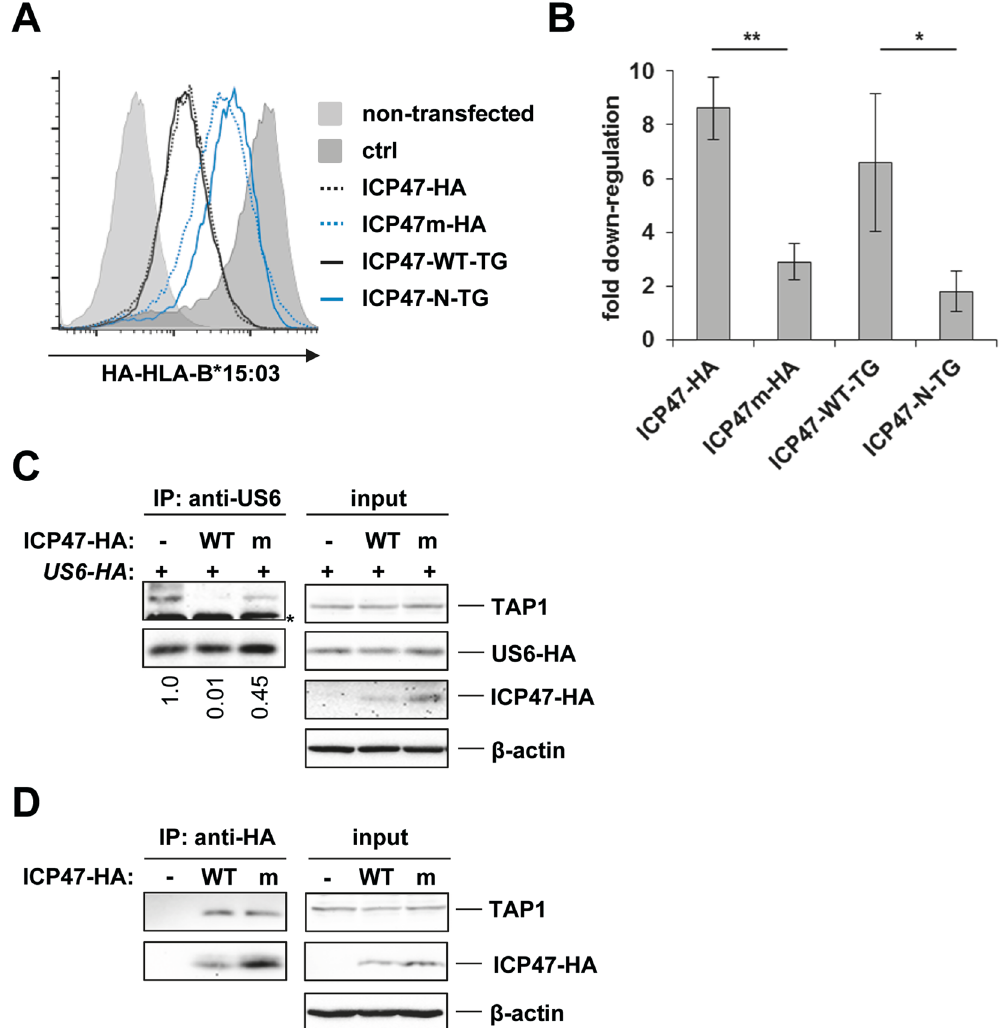
Figure 3. The highly conserved ICP47 residues 50–52 are required for freezing of the TAP conformation. ( A ) HeLa cells were transiently transfected with HA-HLA-B * 15:03, a control (ctrl) or ICP47 constructs as indicated and a plasmid encoding EGFP for gating of transfected cells. At 20 h post-transfection HA- HLA-B * 15:03 surface expression was analyzed by FACS using anti-HA antibodies. One representative experiment out of four independent experiments is shown. ( B ) Relative downregulation of HA-HLA-B * 15:03 was determined by dividing the MFI value of the control sample by the MFI of indicated samples. Mean values of four independent experiments are shown. Statistical analyses were performed applying one-way analysis of variance, ANOVA (Bonferroni), * P < 0.05. ( C ) Control HeLa cells ( − ) or HeLa cells stably expressing WT or mutant (m) ICP47-HA were transiently transfected with US6-HA. At 20 h post-transfection cells were lysed in digitonin lysis buffer and an IP was performed an anti-US6 antiserum. Recovered proteins (IP) and aliquots of the lysates (input) were separated by SDS-PAGE and detected in Western blot (TAP1, 148.3; ICP47-HA and US6-HA, anti-HA). The relative intensity of the TAP1 band compared to the US6-HA band in the IP samples is given below the upper panel. The value of the control sample was set to 1. One representative experiment out of three independent experiments is shown. The asterisk indicates the HC of the antibody used for IP. ( D ) HeLa cells stably expressing ICP47-HA or ICP47m-HA were lysed in digitonin lysis buffer and an IP was performed using an anti-HA antibody. Detection was performed as in C. One representative experiment out of two independent experiments is